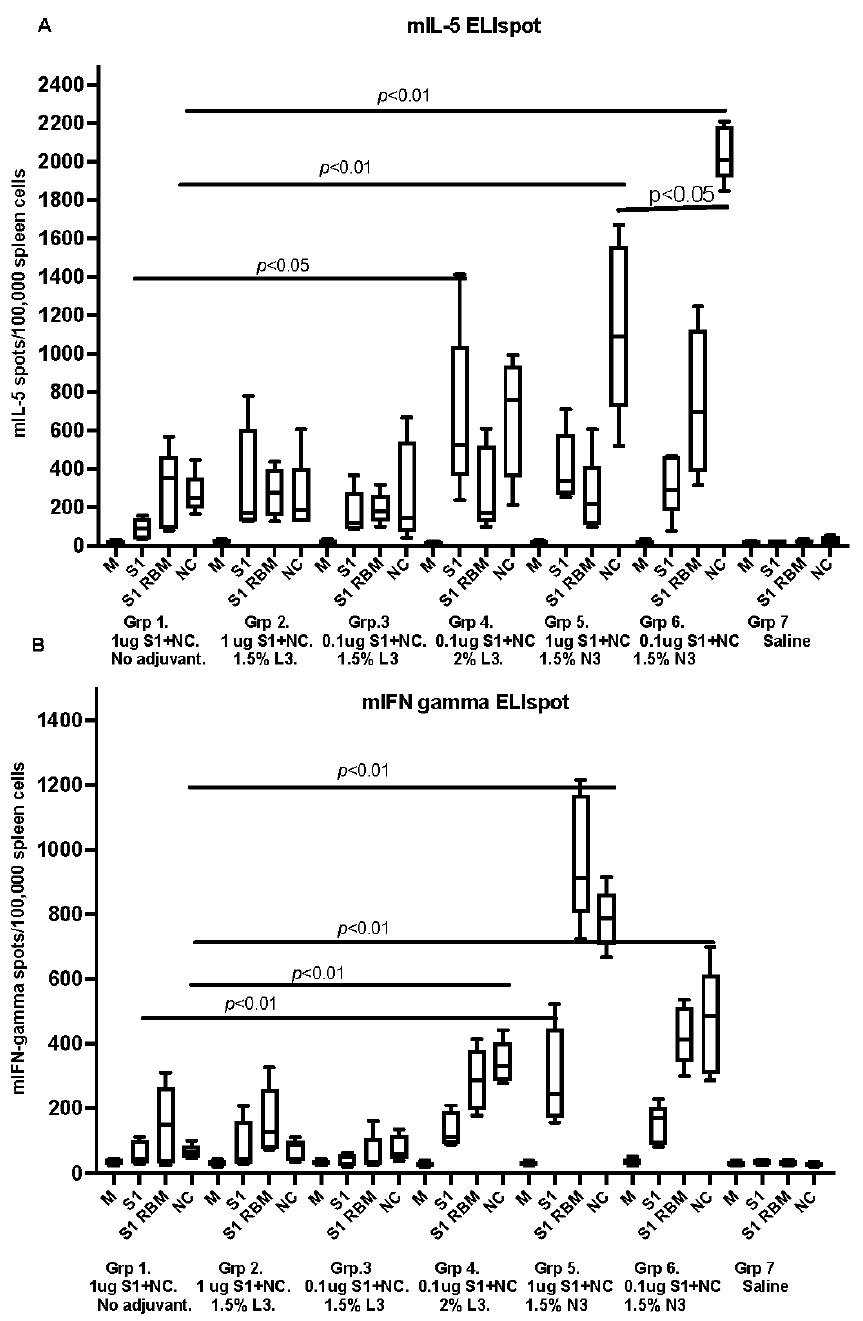
Figure 4. The graphs represent IL-5 and IFN-gamma secreted by spleen cells after vaccinating murine groups with the formulated vaccines. Graphs ( A , B ) show IL-5 and IFN-gamma secreted in blood collected on sacrificing day (post the second immunizing dose) and analyzed by ELIspot. Samples tested antigens used were cell culture medium (M) as negative control and 1 µ g/mL of recombinant S1 spike protein, S1 receptor-binding motif antigen (S1 RBM) and 1 µ g/mL nucleoprotein (NC) with cells from the respective study group. Data are driven from five individuals, p value <